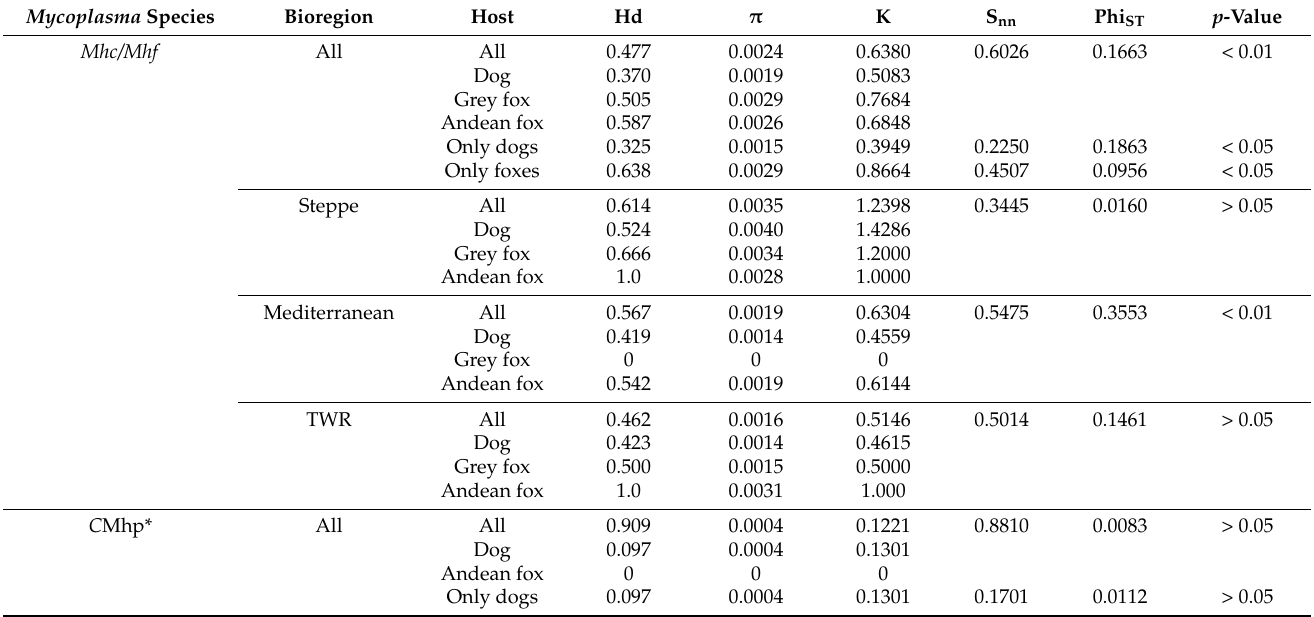
Table 6. Genetic diversity and polymorphism of the 16S rRNA gene sequences of Mycoplasma haemocanis / Mycoplasma haemofelis and Candidatus Mycoplasma haematoparvum detected in different canid hosts in Chile.